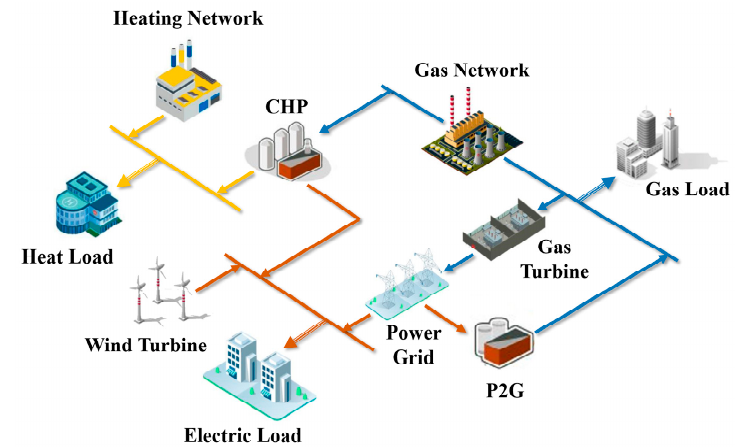
Figure 1. Structure of electricity–gas–heating system.